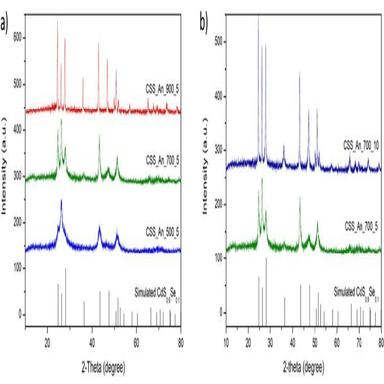
XRD patterns of CSS products prepared via (a) variation of annealing temperature and (b) variation of annealing time.